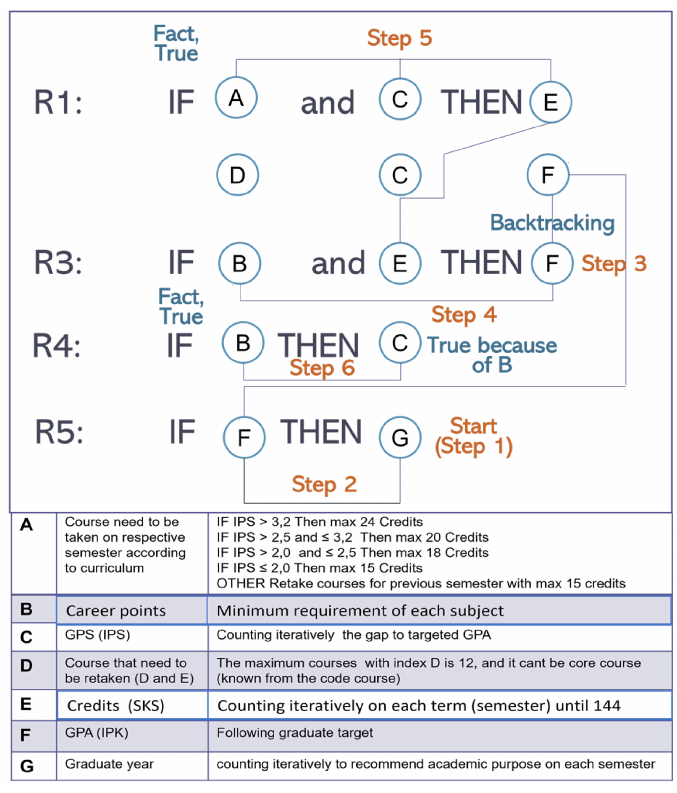
Fig. 1. Backward chaining model of the proposed